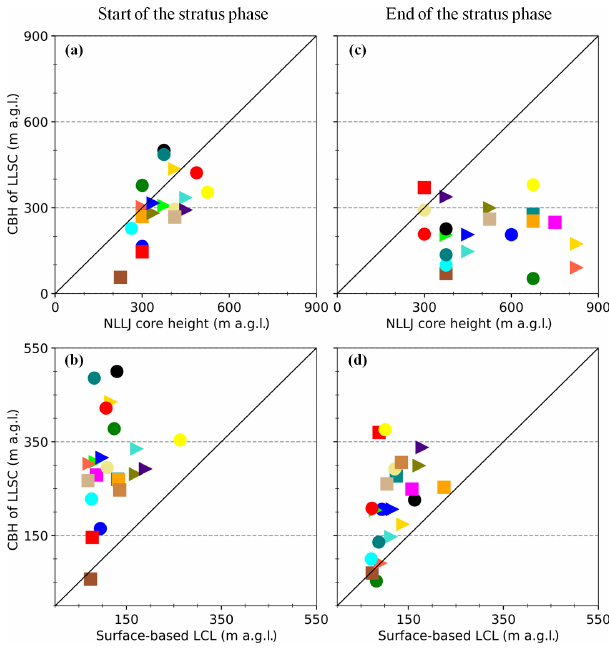
Figure 3. LLSC base height (CBH) against nocturnal low-level jet (NLLJ) core height (a, c) and surface-based lifting condensation level (LCL) (b, d) at the start (a, b) and at the end (c, d) of the stratus phase. Each of the 22 selected cases is represented by a different